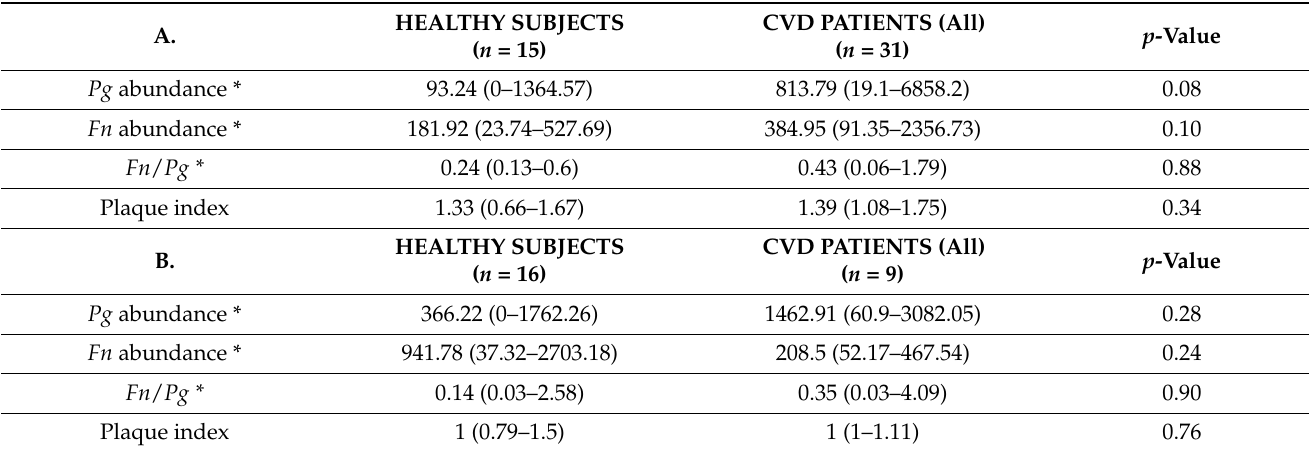
Table 4. Pg and Fn abundance: Comparison between healthy subjects and all patients with previously diagnosed CVD according to sex (( A ), males, and ( B )